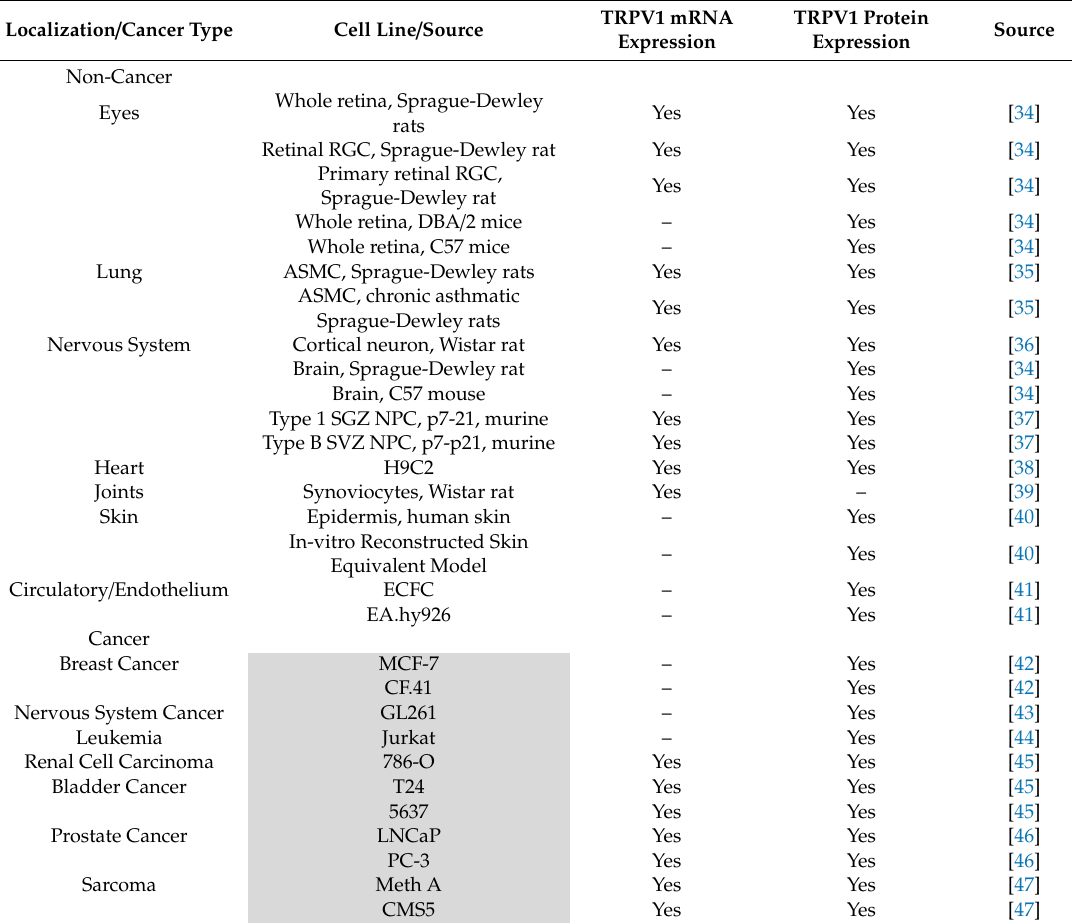
Table 1. mRNA and protein expression of the transient receptor potential vanilloid 1 (TRPV1) ligand-gated ion channel in a variety of cell lines. TRPV1 receptor expression is well characterized in the nervous and optic systems and less so in the muscular and skeletal systems. Cancerous cells lines are highlighted in